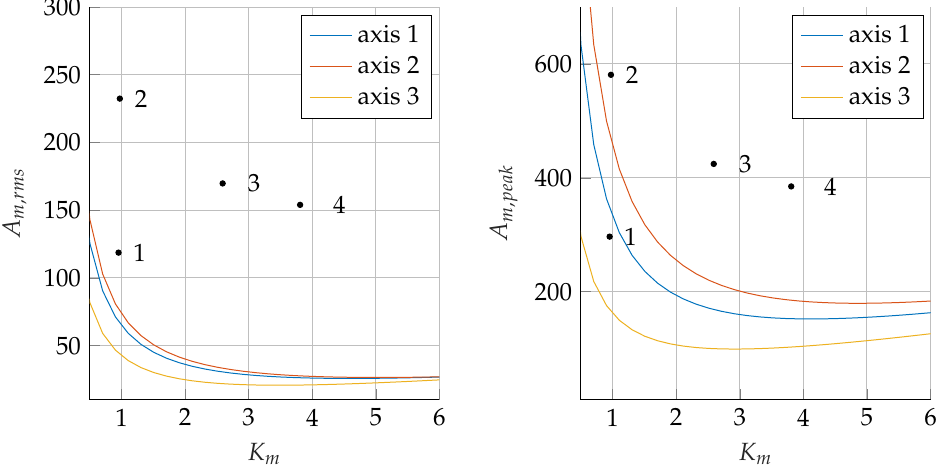
Figure 24. PDS points and load curves (one for each axis) at maximum payload (inertial loads only). The left panel represents the A m , rms curves and the P pds , rated points of the candidate power drive systems; the right panel represents instead the A m , peak curves and the P pds , max